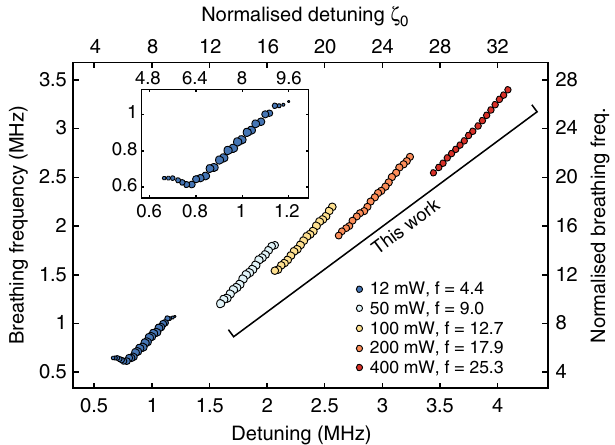
Fig. 6 Simulated evolution of the breathing frequency as a function of the detuning and pump power. The breathing frequency is normalised to the half width at half maximum of the cavity (2 f b / κ ). In these simulations, we assumed κ /2 π = 250 kHz